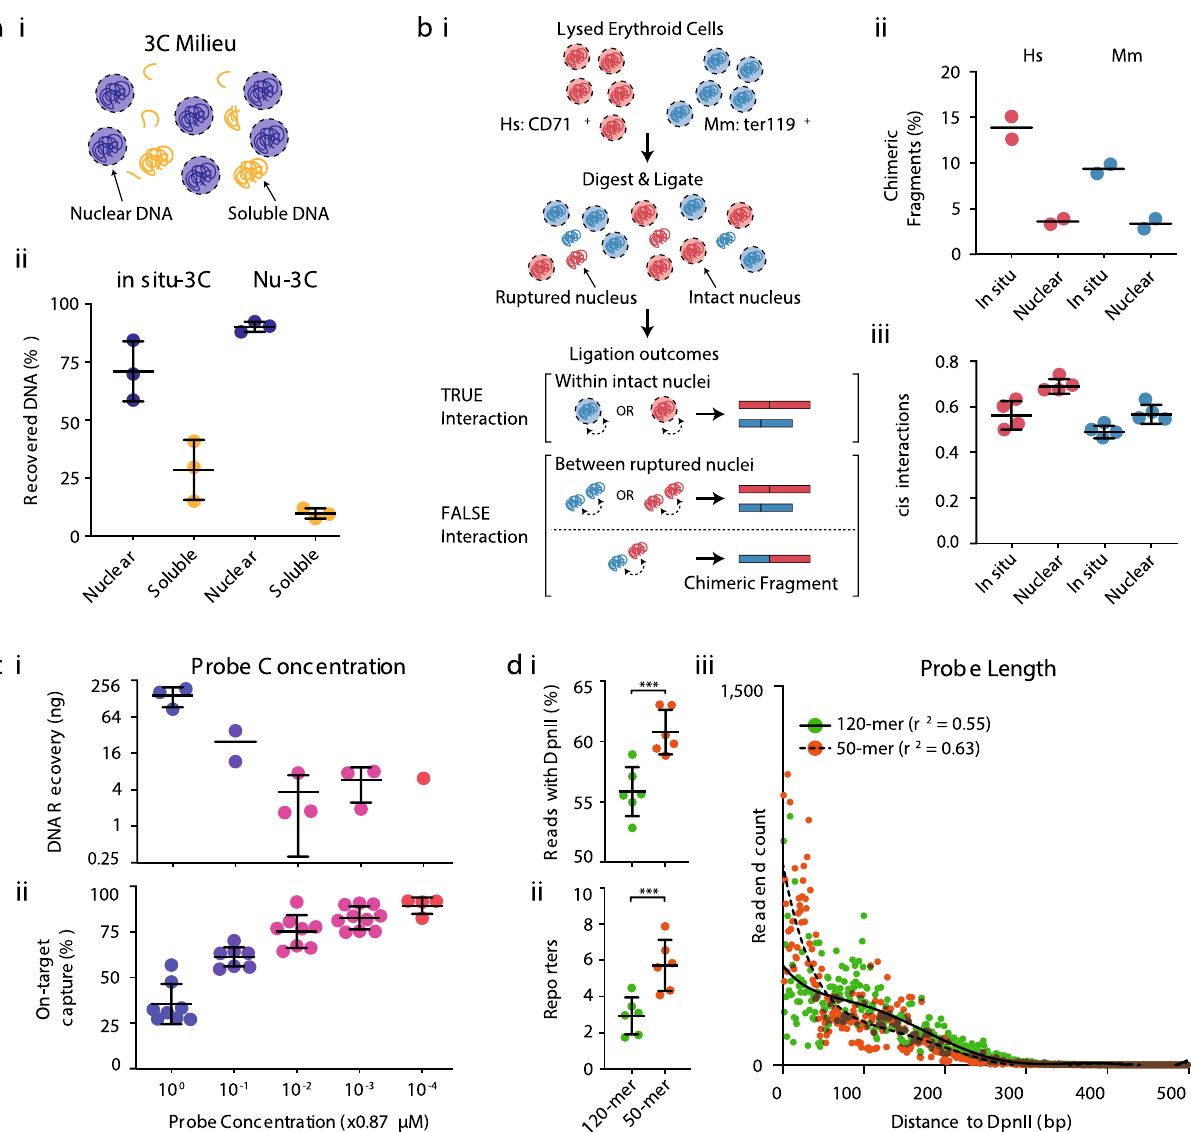
Fig. 1 Nuclear-Titrated Capture-C minimizes noise while maximizing on-target enrichment. a ( i ) During digestion and ligation nuclei can shear leading to free soluble chromatin. Intact nuclei can be separated from freed material by centrifugation. ( ii ) Percent of total DNA recovered in the two fractions using standard in situ-3C and a modi fi ed Nuclear 3C (Nu-3C) approach. n = 3 independent experiments. Bars show mean and one standard deviation. b ( i ) Lysed erythroid cells from human and mouse were mixed in a 1:1 ratio prior to generation of 3C libraries. Ligation occurring between ruptured nuclei can be detected as inter-species chimeric DNA fragments after fi ltering for sequences that map to both genomes. ( ii ) Level of inter-species chimeras and ( iii ) number of reported cis interactions when using standard in situ-3C or modi fi ed Nuclear 3C (Nu-3C) at the Hba-1/2 and Slc25a37 promoters ( n = 2 viewpoints from two independent libraries). Bars show mean and one standard deviation. c Total yield of DNA recovered following single capture ( n ≥ 1 independent capture experiments where each dot is an independent capture) ( i ) and total number of mapped reads containing on-target capture sequence following double capture ( n ≥ 4 libraries from multiple independent captures, where dots indicate libraries) ( ii ) when 11 probe pairs were used at fi nal concentrations ranging from 0.87 µ M to 87 pM. For DNA recovery each dot is a multiplex capture with between 3 and 6 libraries. Bars show mean and one standard deviation. d Percent of reads with a Dpn II site ( i ), number of PCR duplicate fi ltered reporters per 100 mapped reads containing a reporter ( ii ) following capture of six 3C libraries with 120-mer and 50-mer oligonucleotides. n = 6 independent experiments. *** p = 0.0001 using a two-sided Mann – Whitney U -test. Bars show mean and one standard deviation. ( iii ) Counts of read-ends generated by sonication breakpoints as the distance to the nearest end of the Slc25a37 viewpoint. Each dot is average depth normalized count at each position for 100,000 mapped reads ( n = 12). Lines of best fi t were generated as a sixth order polynomial with r 2 shown in the legend. Source data are available in the Source Data fi previously was a criticism of the method 12 . Another signi fi cant cost for NG Capture-C has been the 120-bp biotinylated oligonucleotides — though current pricing is signi fi cantly reduced. We performed capture with 50-bp oligonucleotides targeted to the well-characterized mouse globin and mitoferrin encoding